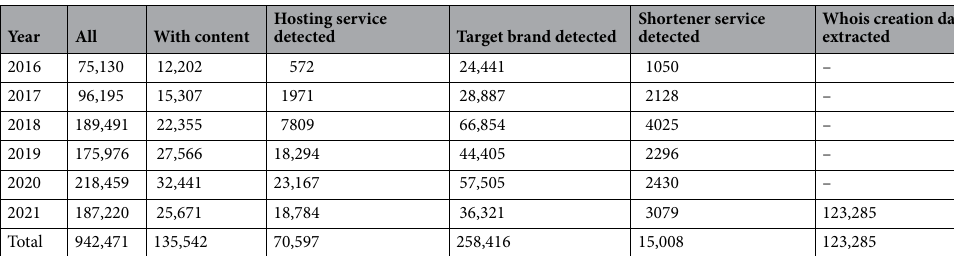
Table 9. Entries content details.